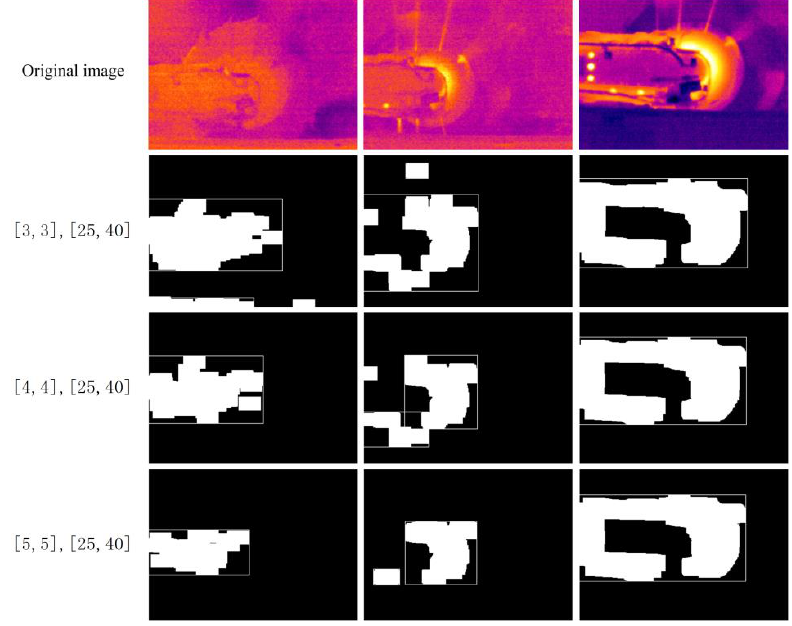
Figure 12. Processing results with different corrosion structure elements.